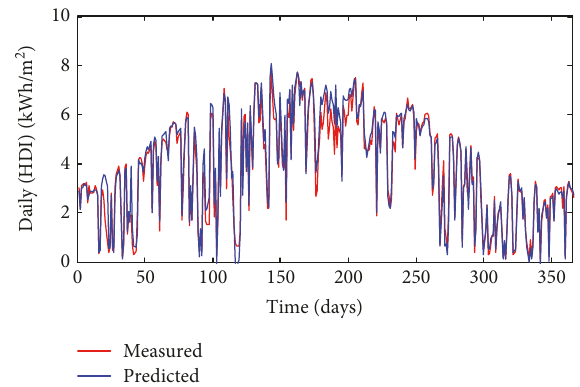
Figure 9: Measured and predicted daily horizontal direct irradiation for test process.